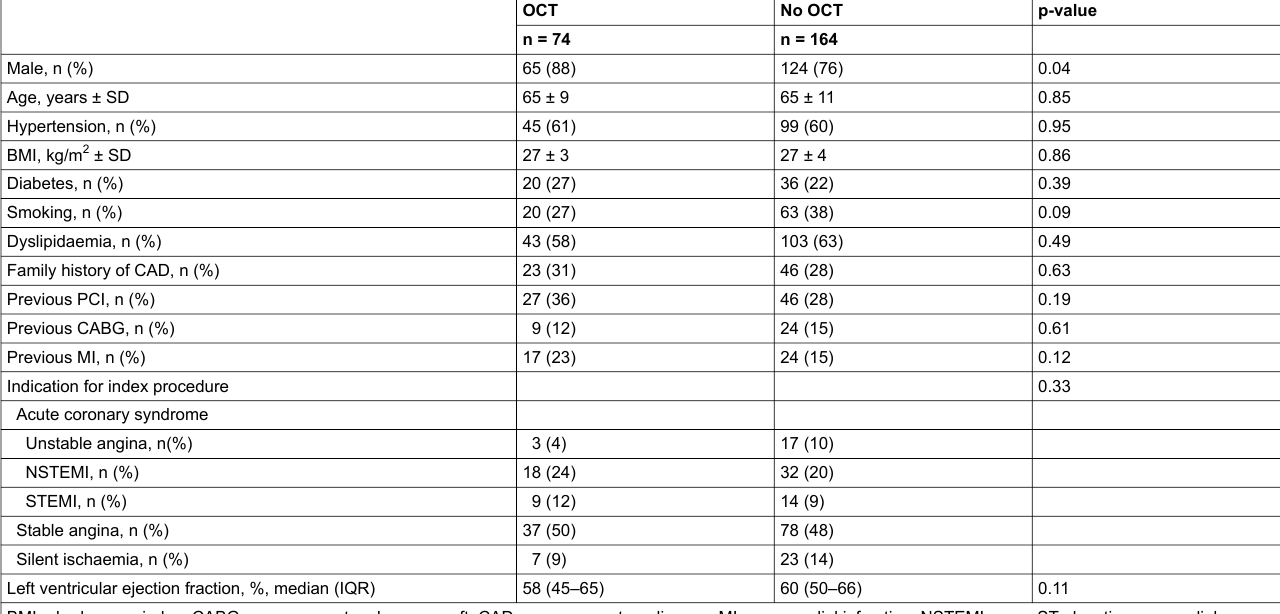
Table S1a: Baseline characteristics of patients included compared with patients not included in the OCT substudy. OCT No OCT p-value n = 74 n =